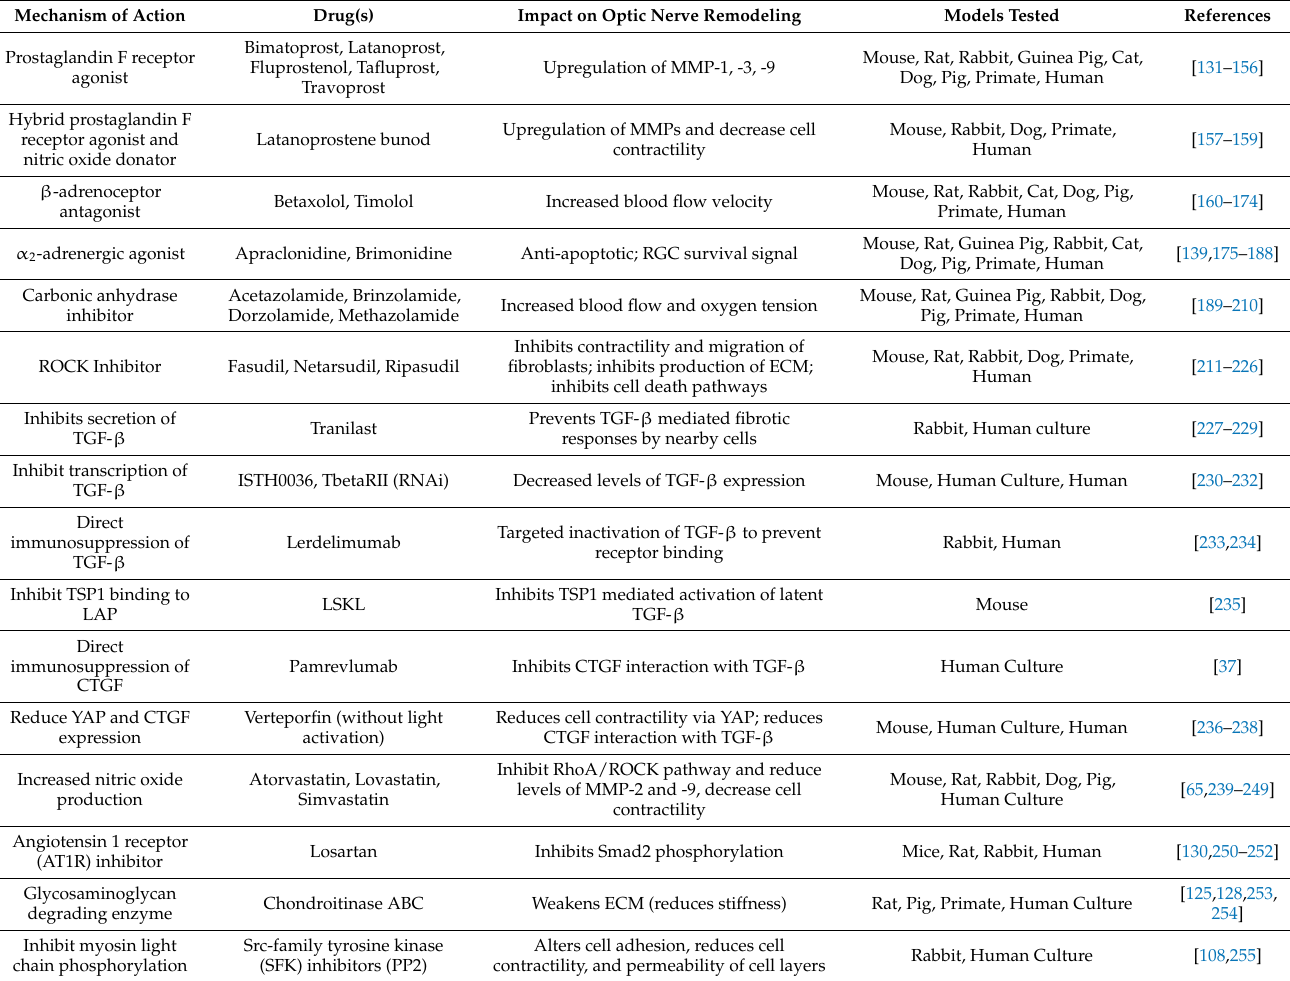
Table 1. Potential therapeutic targets to alter glaucomatous